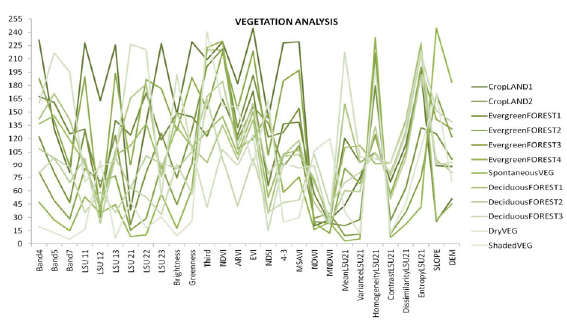
Figure 4. Example of the spectral library for vegetation classes Automated pixel-based multispectral classification of our multi- indices imagery is applied by using Minimum Distance